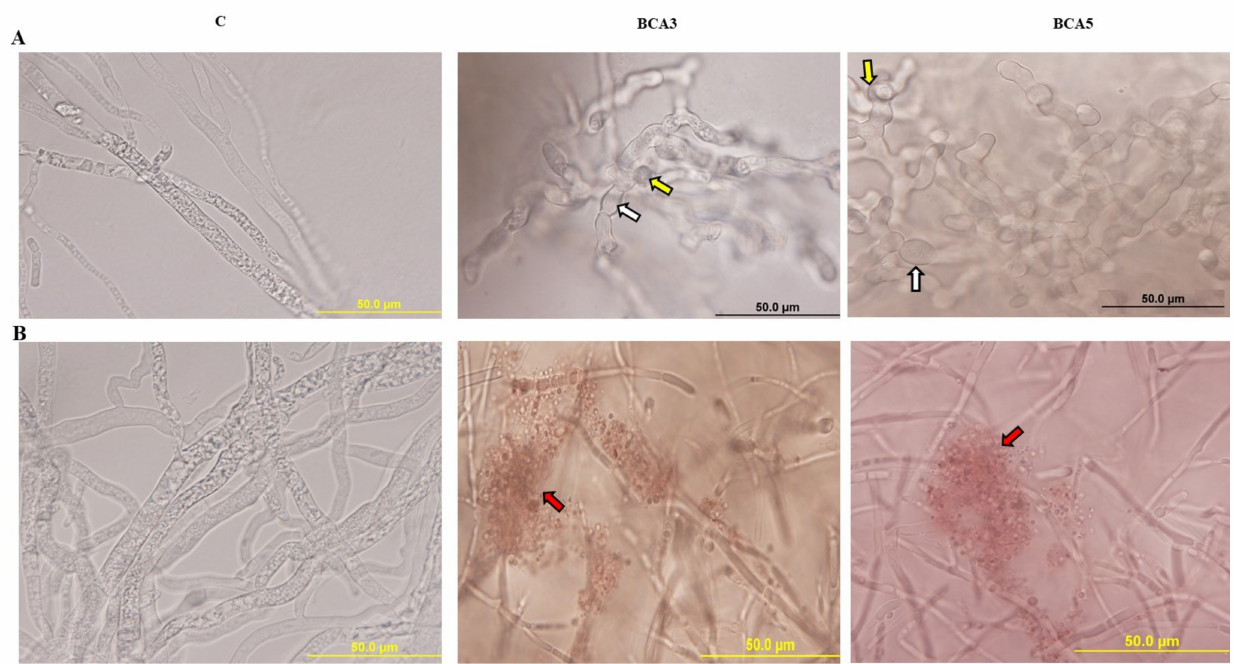
Figure 3. Effect of the culture filtrate of the BCA candidates on hyphae and cytoplasm of Neoscytalidium dimidiatum. Abnormalities observed in hyphal morphology and cytoplasmic contents of N. dimidiatum, following exposure to a filter- sterilized crude culture filtrate of BCAs on ( A ) FMEB, or ( B ) CCB compared to control. White and yellow arrows point to hyphal septum malformation and branch deformation, and cytoplasmic coagulation, respectively. Red arrows point to lysis of cytoplasm. Light microscopy images were taken at 1000 × magnification. C, control (no BCA was applied). Isolates #21 (BCA3) and #45 (BCA5) represent Streptomyces griseorubens UAE2 and Streptomyces wuyuanensis UAE1, respectively. FMEB, fish meal extract broth; CCB, colloidal chitin broth; BCA, biological control